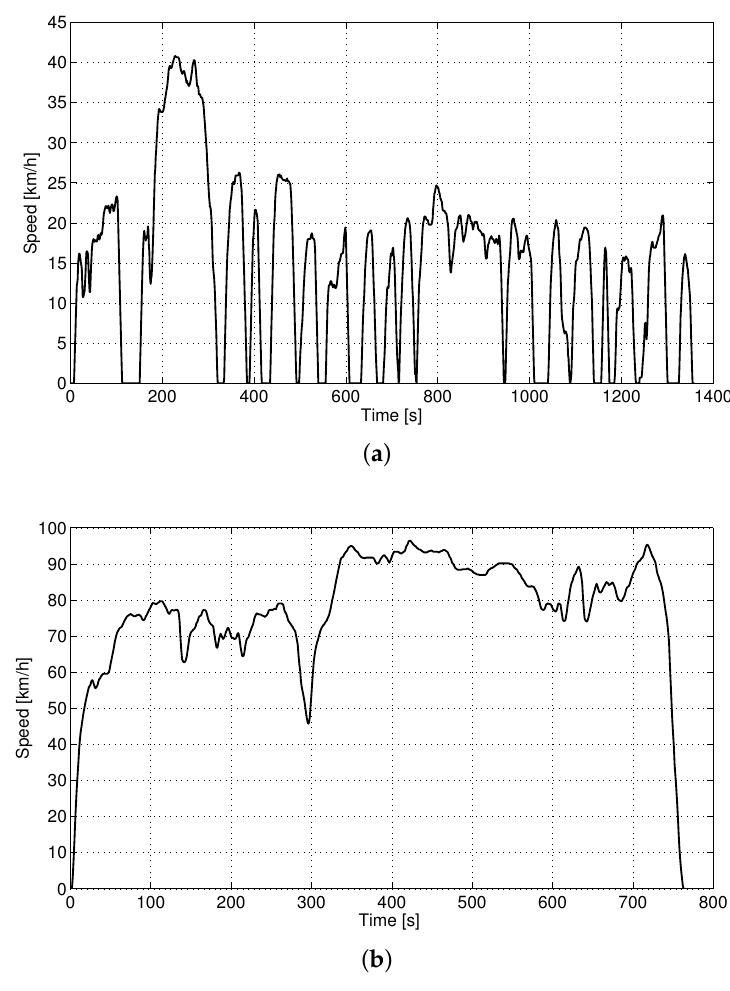
Figure 7. Driving speed profiles. ( a ) FUDS speed profile; ( b ) FHDS speed